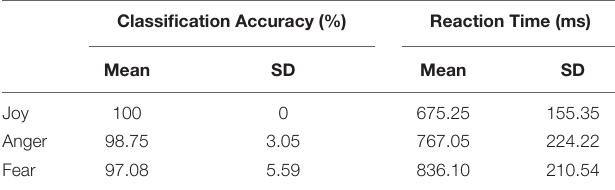
TABLE 2 | Behavioral results (mean % and standard deviations